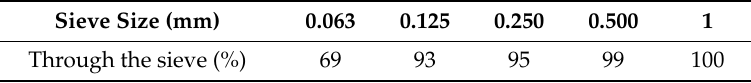
Table 3. Particle size distribution of limestone sludge.